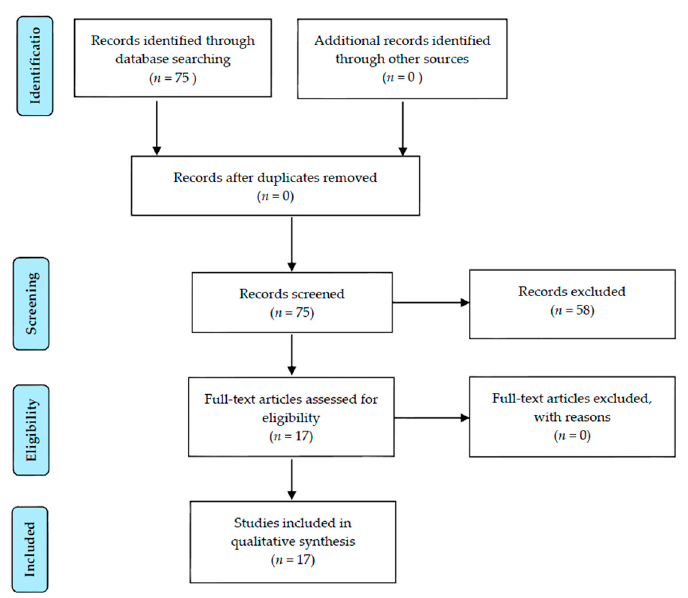
Figure 1. Prisma flow diagram.